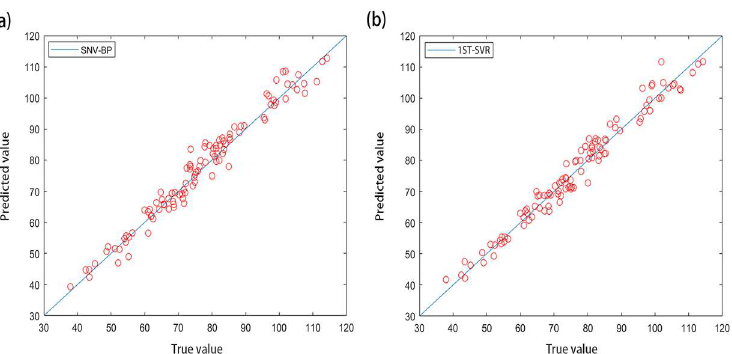
Figure 4. ( a , b ) represent the fitting results of the SNV-BPNN model and 1ST-SVR model based on full frequency band, respectively. full frequency band,